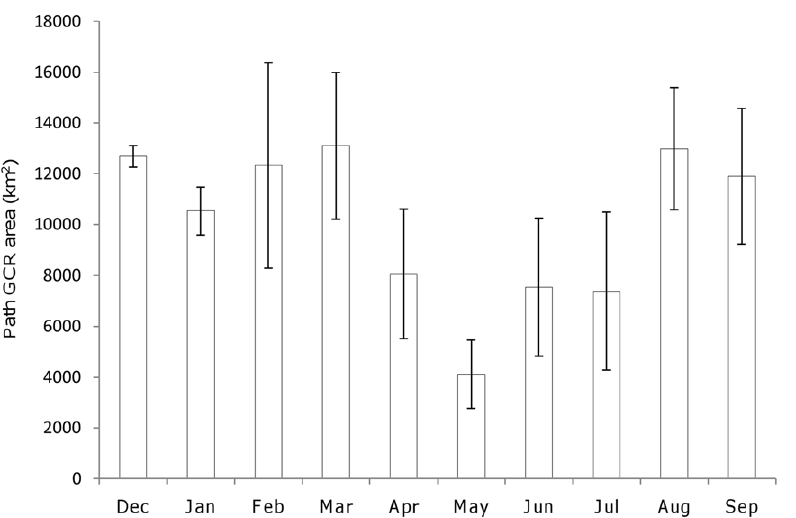
Figure 3. Mean ( ± SE) path GCR estimates for individual months for six immature African white-backed vultures. Due to differences in tracking periods for individuals, estimates were calculated for four vultures for December to March, and five vultures from April to September, inclusive.